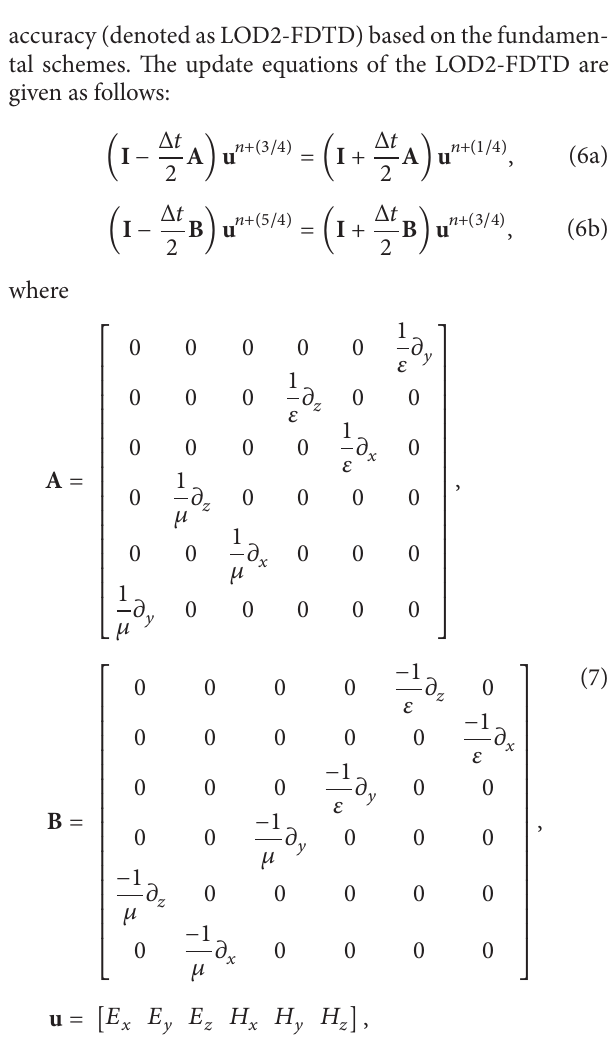
Figure 2: Metal embedded in the